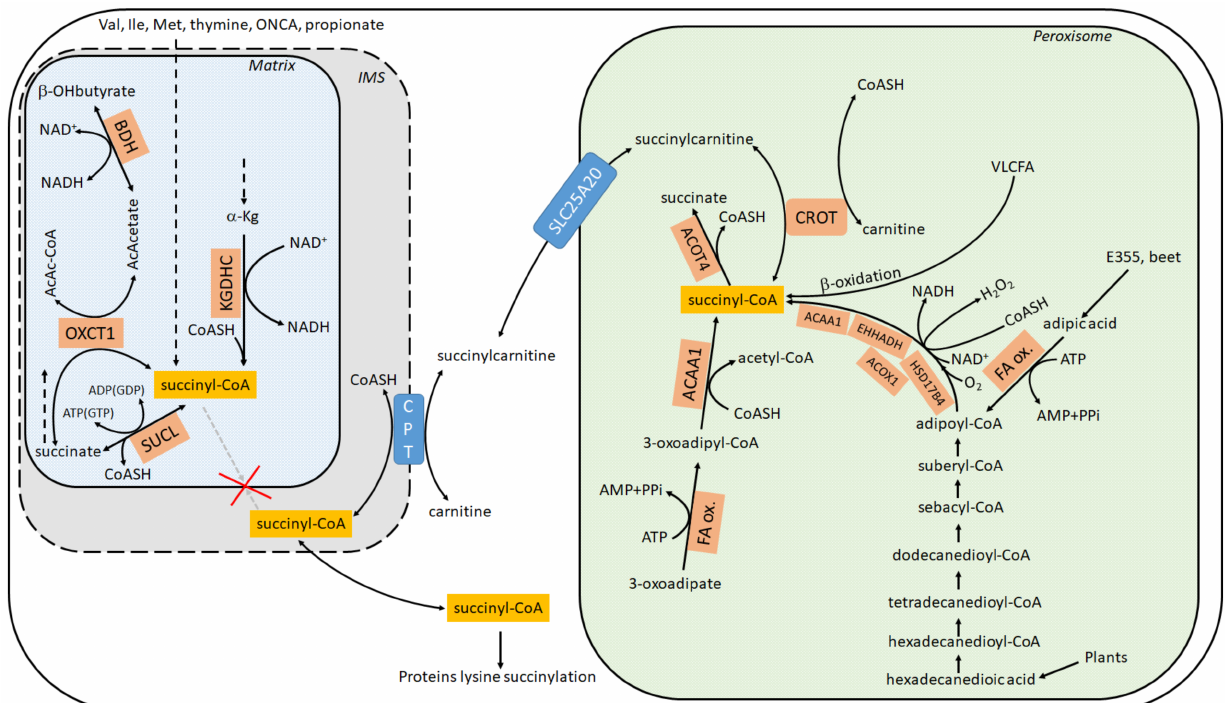
Figure 1. Metabolic pathways leading to succinyl-CoA, in cytosol, mitochondria and peroxisomes. ACAA1: acetyl- CoA acyltransferase 1; ACOT4: acyl-CoA thioesterase 4; ACOX1: acyl-CoA oxidase 1; a-Kg: alpha-ketoglutarate; BDH: beta-hydroxybutyrate dehydrogenase; b-OHbutyrate: beta-hydroxybutyrate; CoASH: coenzyme A; CPT: carnitine palmi- toyltransferase (I); CROT: carnitine O-octanoyltransferase; E355: manufactured E number food additive; same as adipic acid; EHHADH: enoyl-CoA hydratase and 3-hydroxyacyl CoA dehydrogenase; FA ox.: fatty acid oxidation HSD17B4: hy- droxysteroid 17-beta dehydrogenase 4; Ile: isoleucine; IMS: intermembrane space; KGDHC: a-ketoglutarate dehydrogenase; Met: methionine; ONCA: odd number chain fatty acid; OXCT1: 3-oxoacid CoA-transferase 1; SUCL: succinate-CoA ligase: Val: valine: VLCFA: very long chain fatty